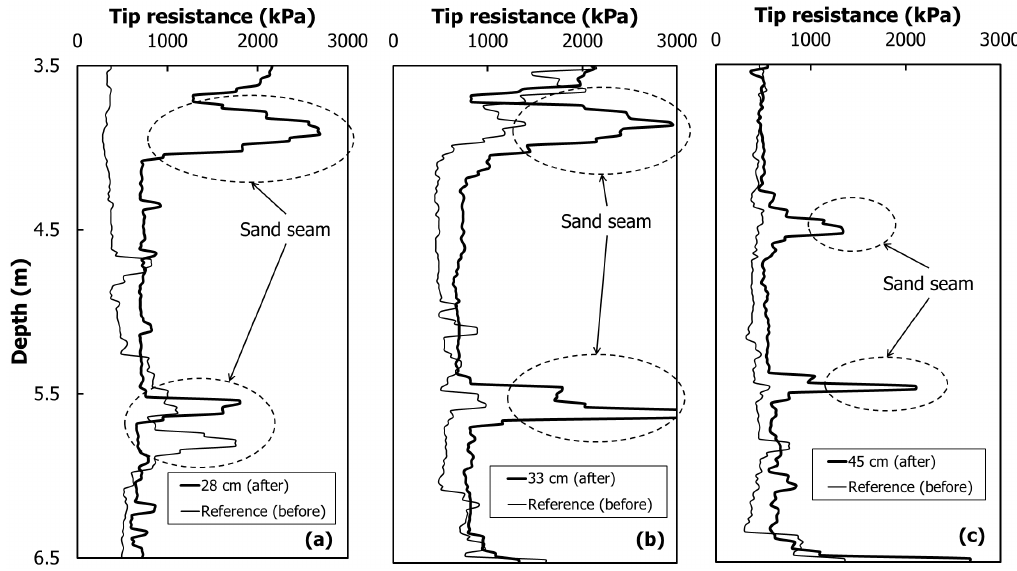
Figure 12. The variation of the tip resistance due to ground heating using an electric heat pipe (Cases 5, 6, and 8), ( a ) a point 28 cm in the horizontal direction; ( b ) 33 cm; ( c ) 45 cm.